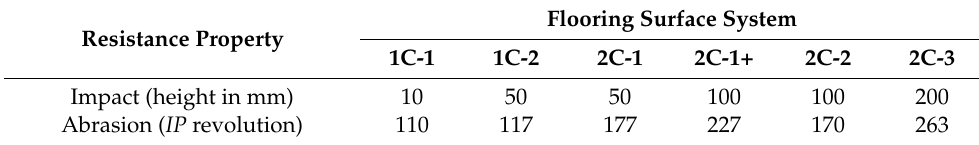
Table 6. Surface resistance to impact and